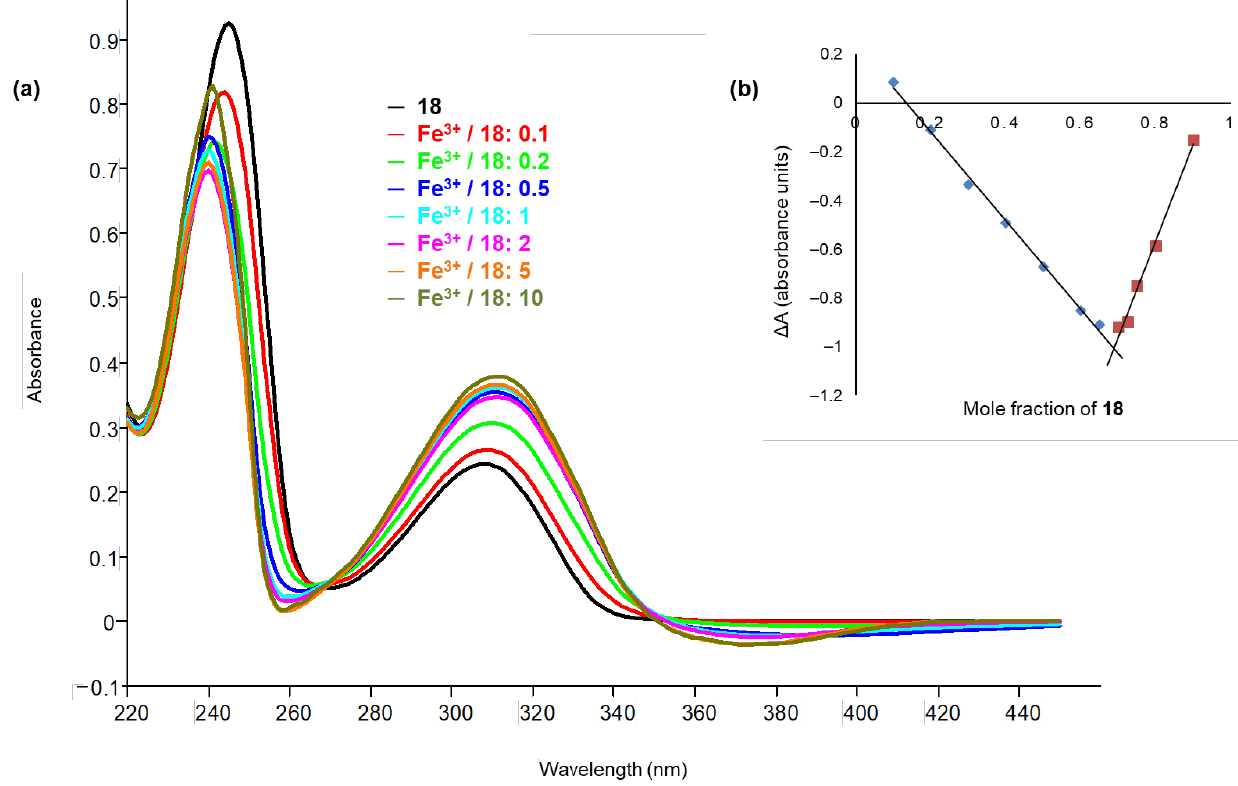
Figure 7. ( a ) UV–Vis titration of ligand 18 with Fe 3+ . The greatest variations in spectra with increasing amount of metal are observed at 245 nm, with a reduction of absorbance, and at 310 nm, with an increase of absorbance. There are two isosbestic points at 267 and 353 nm. ( b ) Job’s plot of compound 18 in presence of Fe 3+ : variation of the absorbance ( ∆ A) at the wavelength of 245 nm, in ordinate, versus the mole fraction of 18 , in abscissa. X (mole fraction that causes the maximum variation of absorbance) = 0.69; n (number of ligand molecules per cation) = 2. Table 5. Job’s plot data for the tested com pounds ( 12 , 14 , 18 ) in presence of Fe 3+ and Cu 2+ . The table shows the wavelength values (λ) in which the absorbance variation was measured, the molar ratios (X) that cause the maximum variation of absorbance and the coordination values (n) which corre- spond to the number of ligand molecules per cation.